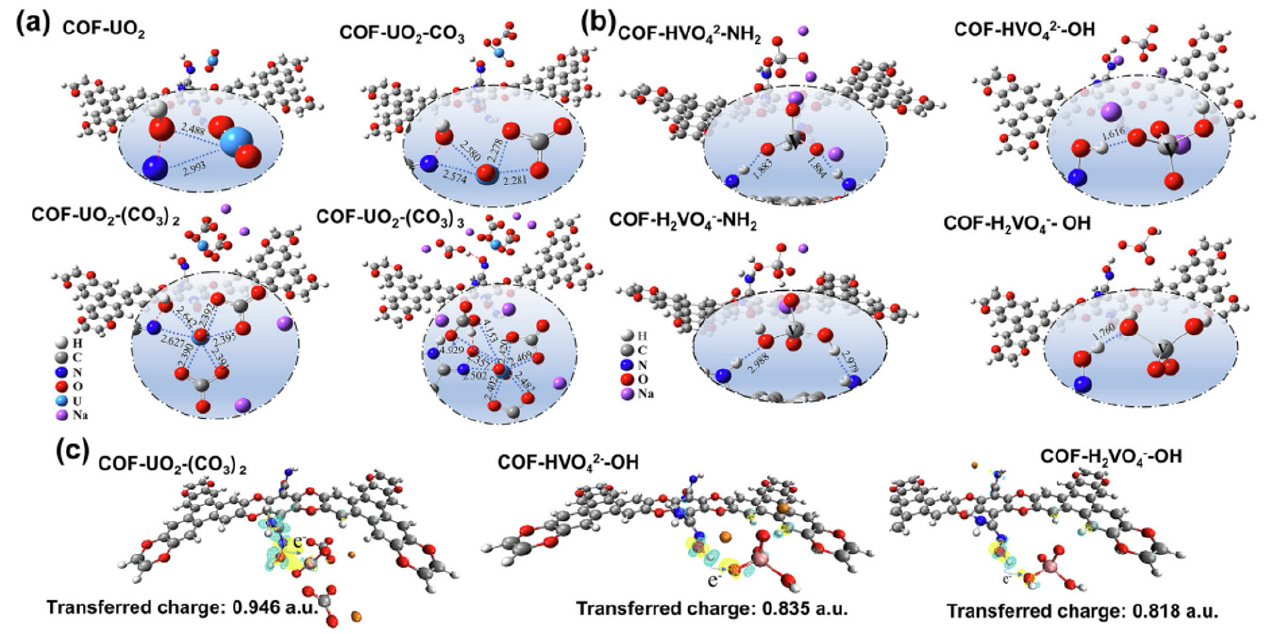
Figure 3. Interaction configuration and binding mechanism between U(VI) or V(V) and COF-HHTF- AO based on DFT simulation. The optimized interaction structures of COF-HHTF-AO with uranyl in the presence of different carbonate contents ( a ) and two forms of vanadium oxide (HVO 42 − and H 2 VO 4 − ) ( b ), which are neutralized by Na ions; bond lengths are in Å, ( c ) Charge density difference of the stable configuration of uranyl, HVO 42 − , and H 2 VO 4 − adsorbed on COF-HHTF-AO. The yellow and cyan regions indicate increases and decreases in charge density, respectively [33], Copyright 2021